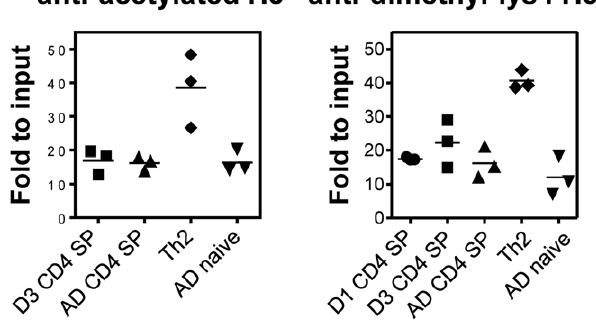
Figure 2. Lack of permissive histone marks at CNS-1 in neonatal thymocytes. Chromatin were prepared from sorted day 1, day 3, or adult CD4 SP thymocytes, from neonatal Th2 effectors, or from adult naı¨ve CD4 + lymph node cells and subjected to chromatin immunoprecipitation using anti-acetylated H3 (left panel) or anti-H3 dimethyl-lys4 (right panel), followed by real-time PCR for CNS-1, as described in Materials and Methods. The horizontal lines are the mean values obtained from 3 independent experiments. Each symbol represents a different experiment.